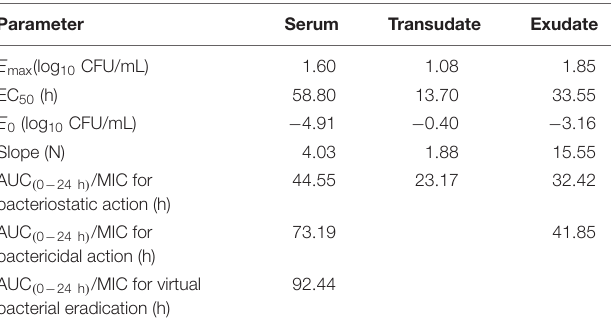
TABLE 6 | Integration of pharmacokinetic and pharmacodynamics data obtained for tulathromycin after administration of 2.5 mg/kg in piglets ( n = 6). Parameter